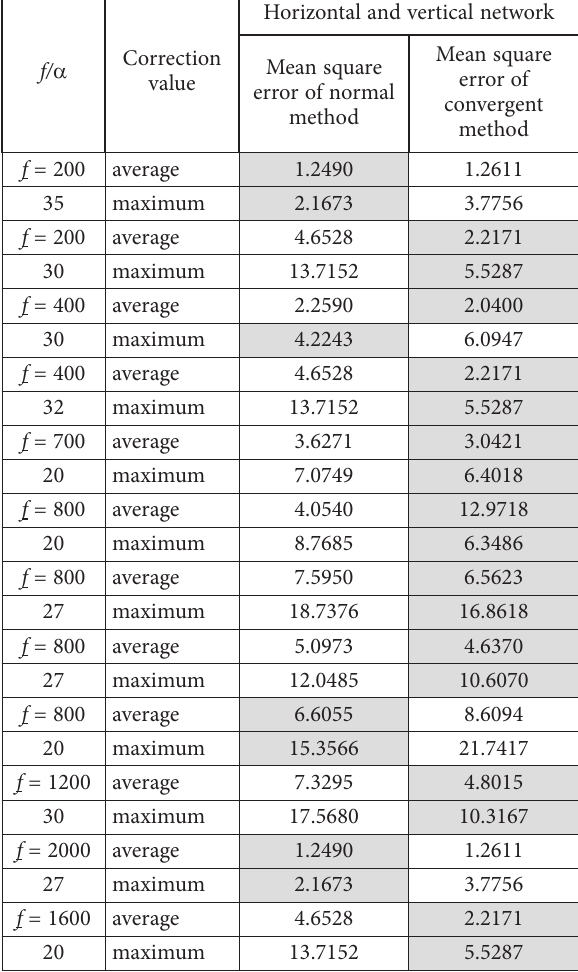
Table 4. The total root mean square error of the horizontal and